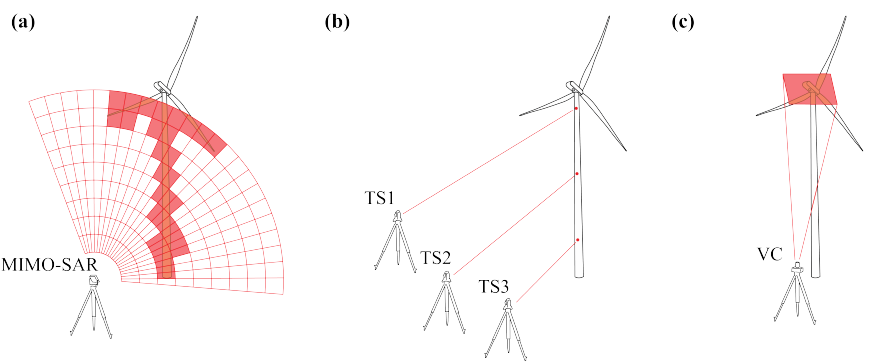
Figure 2. Illustration of the measurement arrangement for the various sensors: ( a ) MIMO-SAR instrument, ( b ) total station, and ( c ) video camera.